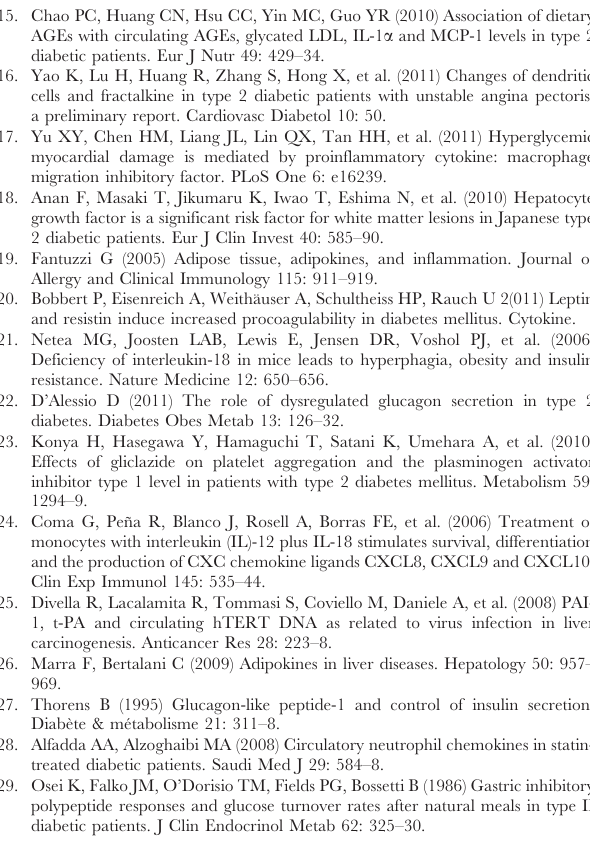
Table S2 Ratio between the mean concentrations of significant molecules in LC versus CHC patients and in LCD vs CHD patients . We have evidenced in bold the ratio .